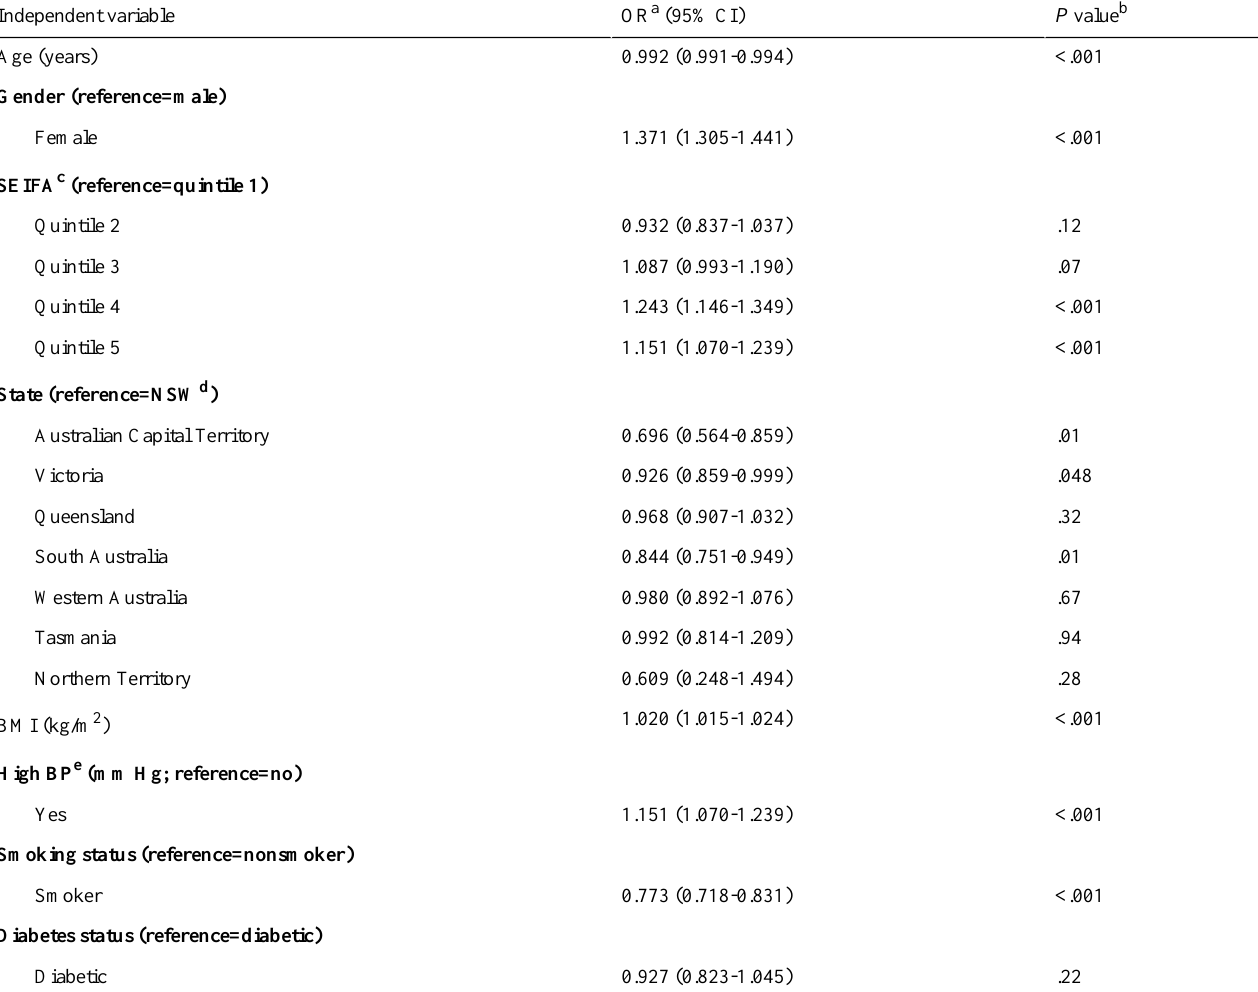
Table 3. Binomial logistic regression analysis with the dependent variable: repeat user